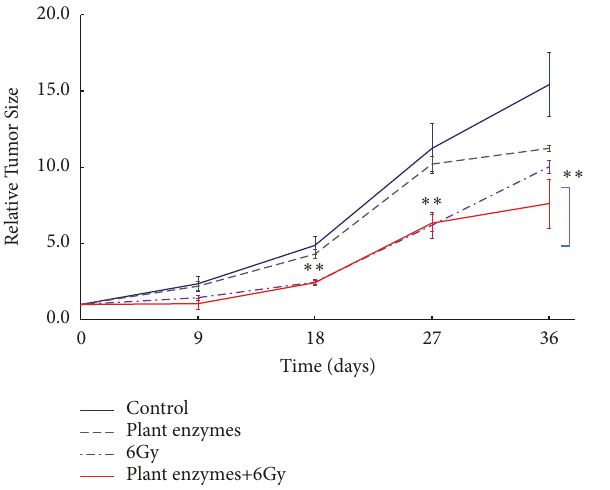
Figure 1: Effect of Validux Plant Enzyme on the tumor growth in mice inoculated with 4T1 (high grade) of mouse prostate cancer cell line. Groups of ten mice each were subjected to each treatment. Results represent means ± SD for 7-8 mice. ∗∗ Significantly different from the Validux Plant Enzyme vs. control group and Validux Plant Enzyme +6Gy vs. 6Gy ( P < 0.01 ).